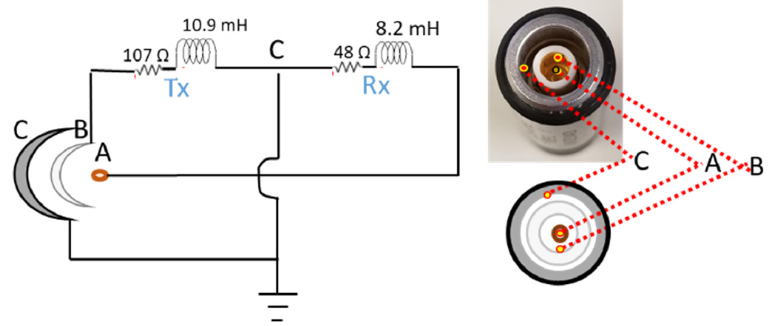
Figure 8. An illustration of the reflection probe circuit.